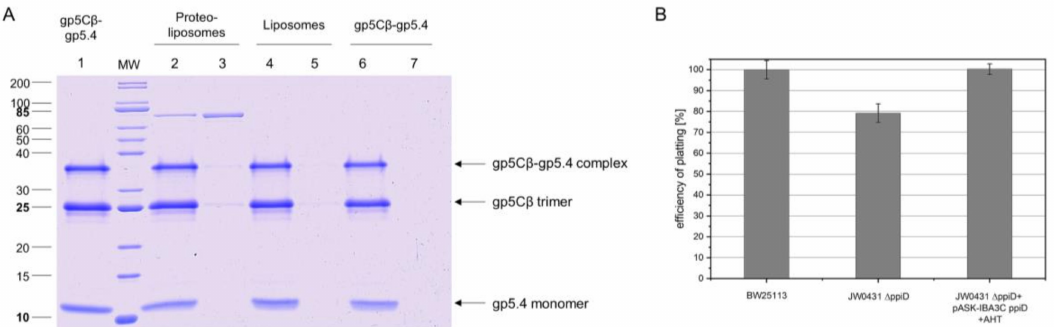
Figure 6. ( A ) Binding of gp5C β –gp5.4 complex to PpiD proteoliposomes. Purified PpiD protein was